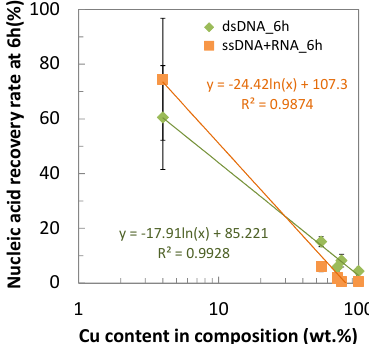
Figure 3. Dependence of nucleic acid recovery rate at 6 h on the copper content in the alloy composition (mean ± standard deviation).